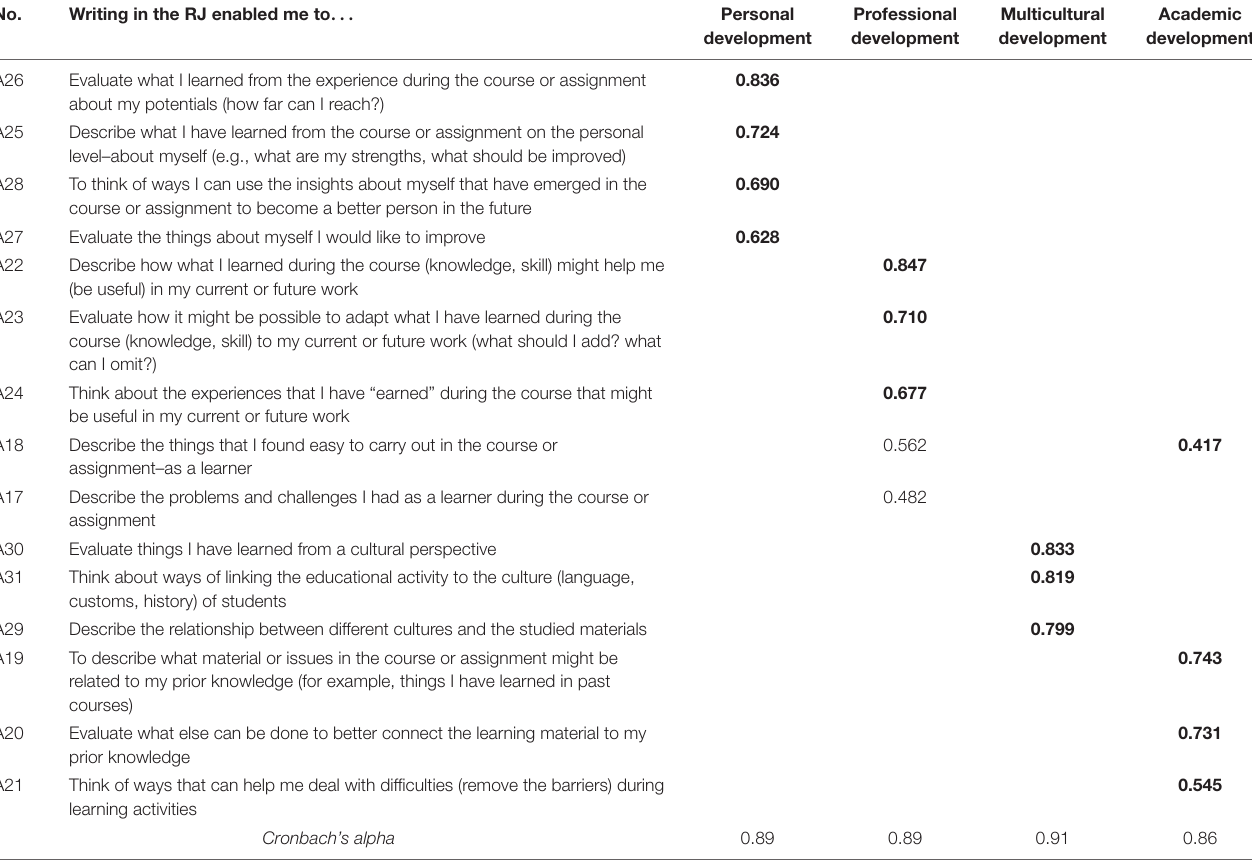
TABLE 3 | The long-term scale: factors, item descriptions, item loadings, and reliability results (Cronbach’s alpha) N = 141. No. Writing in the RJ enabled me to